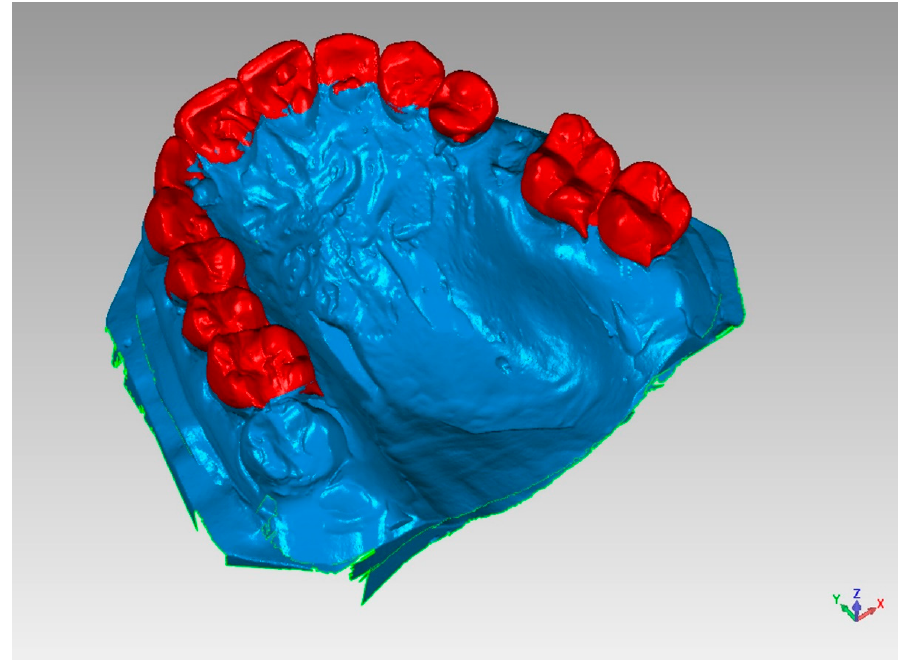
Materials 2021 , 14 , x FOR PEER REVIEW Figure 2. Optical scan of study models for the analysis of volumetric variations.